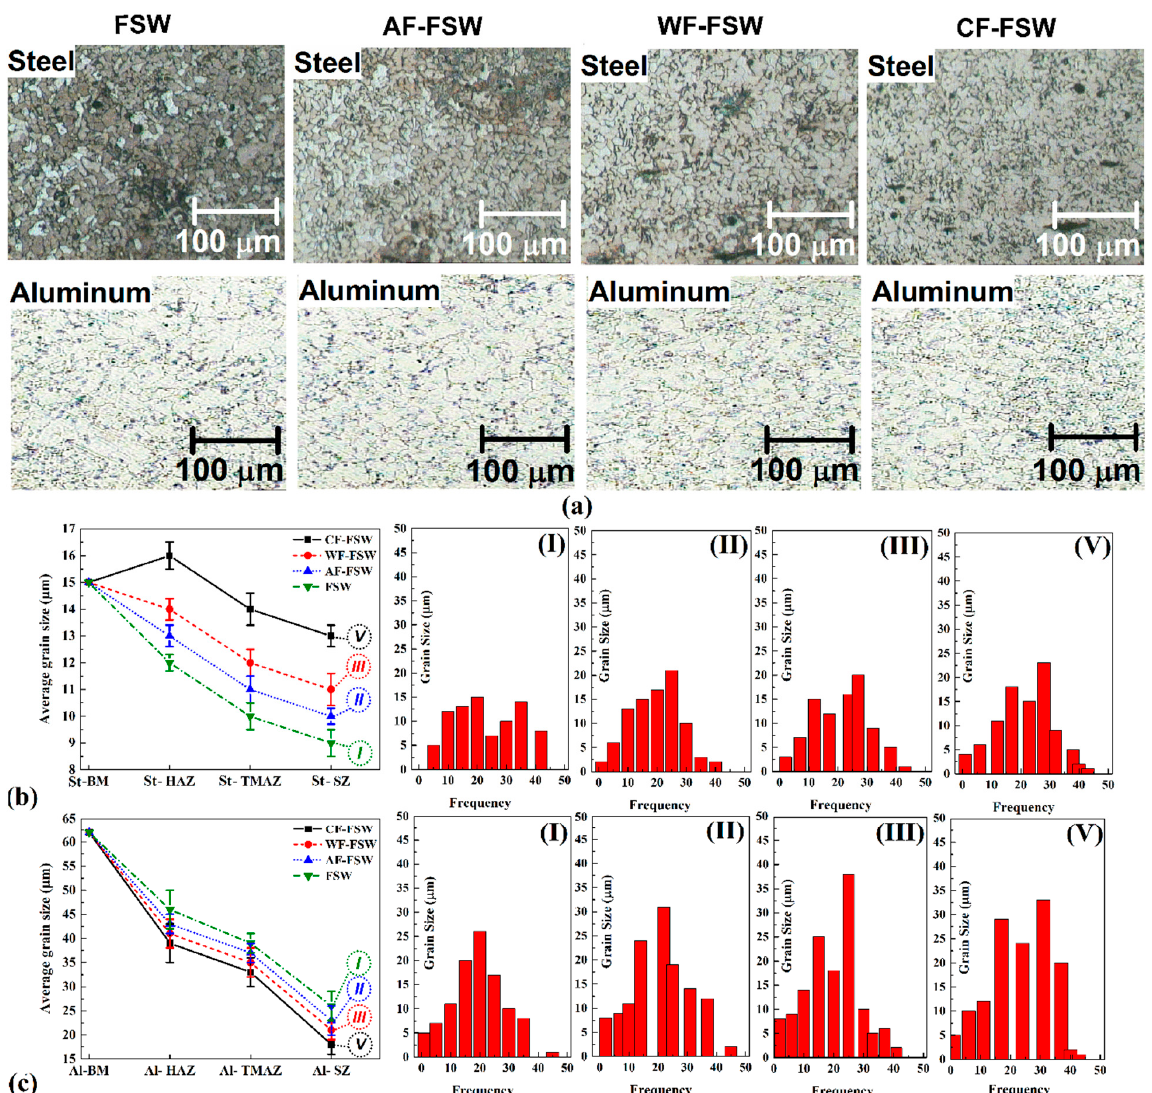
Fig. 5 Figure 5. ( a ) Optical microscopy (OM) microstructure observations of various stir zone, ( b ) average grain size of steel side for different cooling conditions with histogram of grain size in stir zone (SZ) and ( c ) average grain size of aluminum side for different cooling conditions with histogram of grain size in